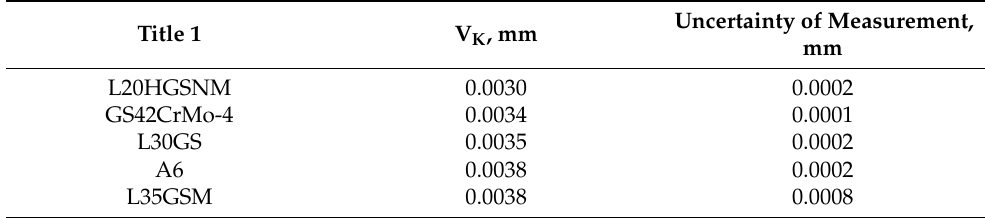
Table 5. Values of wear caused by electrochemical corrosion not supported by friction VK determined for the analyzed materials.